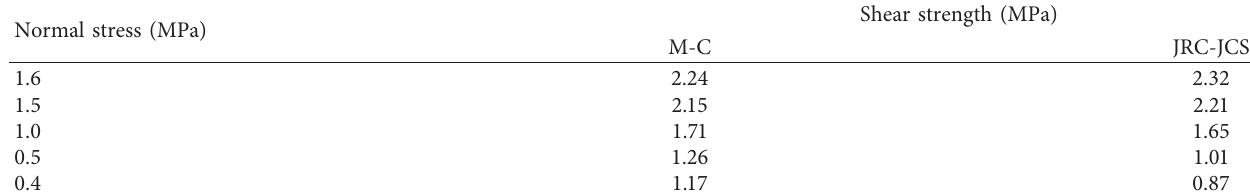
Table 2: Shear strength at different normal stress levels.